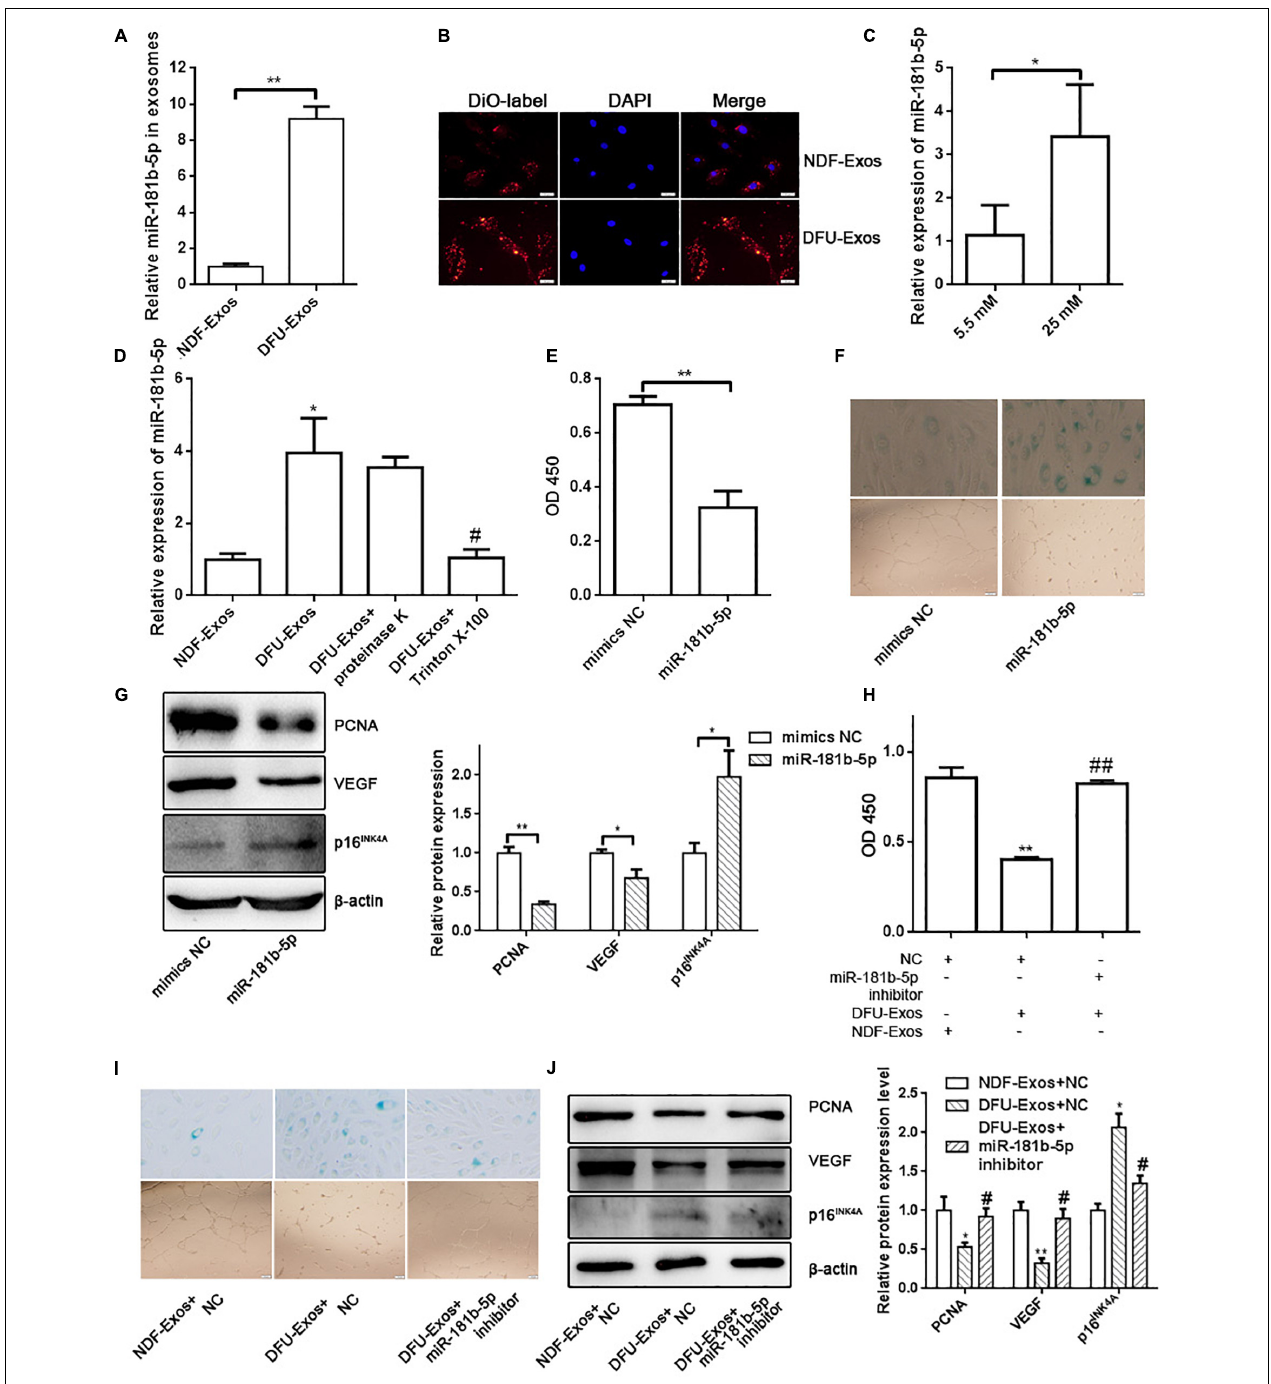
FIGURE 2 | Exosomal miR-181b-5p from DFU-Exos promoted cell senescence and inhibited tube formation in HUVECs. (A) miR-181b-5p expression in NDF-Exos and DFU-Exos detected by qRT-PCR. ** P < 0.01 DFU-Exos vs. NDF-Exos. (B) DiO-labeled showing the uptake of exosomes by HUVECs. (C) miR-181b-5p level in exosomes isolated from HUVECs cells grown in culture medium containing 5.5 mM or 25 mM glucose. * P < 0.05 5.5 mM vs. 25 mM. (D) miR-181b-5p level in HUVECs was detected by qRT-PCR. * P < 0.05 vs. NDF-Exos, # P < 0.05 vs. DFU-Exos. CCK-8 assay (E) , β -gal staining and tube formation (F) were used to detect the effects of miR-181b-5p on cell viability, cell senescence and tube formation. ** P < 0.01 miR-181b-5p vs. mimics NC. (G) Western blotting showing the expression of PCNA, VEGF, and p16 INK4A in HUVECs overexpressing miR-181b-5p. * P < 0.05, ** P < 0.01 miR-181b-5p vs. mimics NC. CCK-8 assay (H) , β -gal staining and tube formation (I) showing cell viability, senescence and tube formation in rescue experiment. ** P < 0.01 vs. NC + NDF-Exos, ## P < 0.01 vs. NC + DFU-Exos. (J) Western blotting showing the expression of PCNA, VEGF, and p16 INK4A in HUVECs. * P < 0.05, ** P < 0.01 vs. NDF-Exos + NC, # P < 0.05 vs. DFU-Exos +